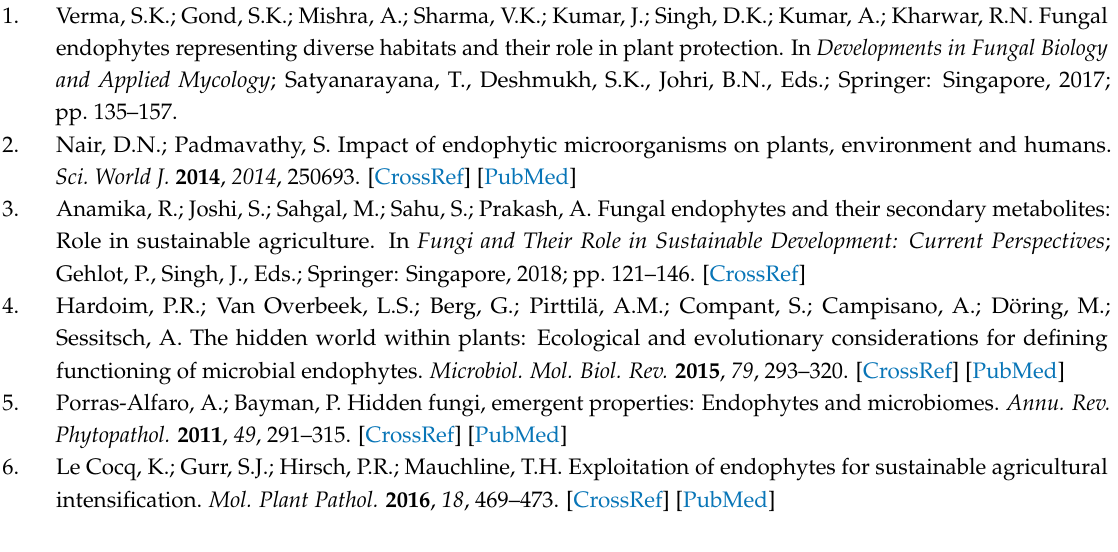
Figure S1: Rarefaction (A) and species accumulation (B) curves., Table S1: Sample characteristics. Note that sample L47_S2011 was sequenced twice (SeqIDs BEWE_a_699 and BEWE_a_719). Table S2: zOTU table for the fungal endophyte community. For further information on the Sample ID see Supplementary Table S1. Table S3: Sequence characteristics (number of sequences) and alpha diversity values of the fungal dataset. Table S4: Significantly (p < 0.05) associated fungal zOTUs with grass species and management practices. Table S5: Putative life strategies of fungal endophytes in 2011. Table S6: Differences in the relative abundances of fungal endophytes between grass species tested by pairwise comparison. Table S7: Differences in the putative life strategies of fungal endophytes between grass species tested by pairwise